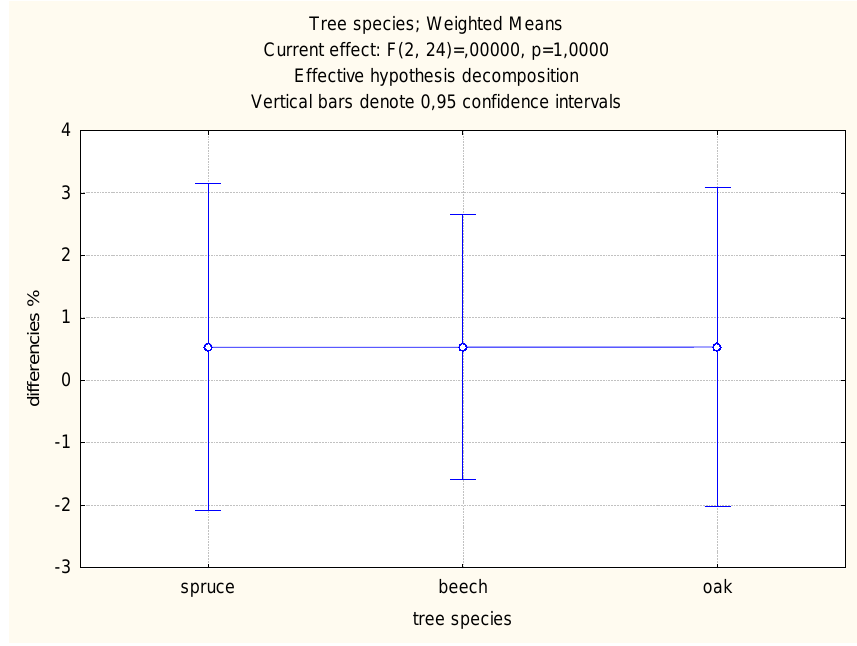
Figure 16. Average values of the differences in the measured and calculated values for each tree species.